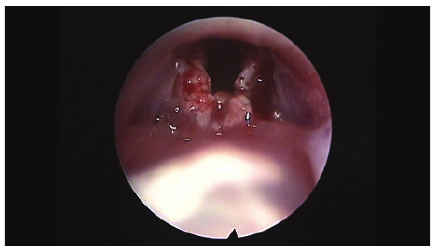
Figure 3: Bilateral trauma on vocal folds.